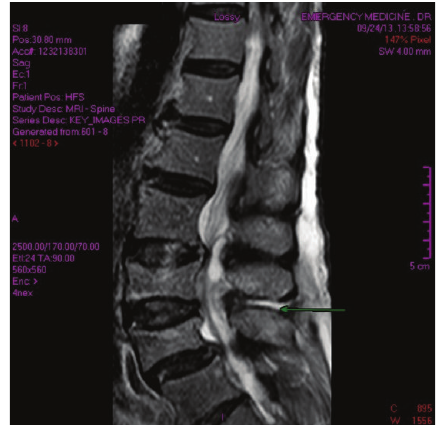
Figure 2: STIR (short-inversion-time inversion recovery) sagittal image. Increased fluid signal intensity is noted in the interspinous region of L3/L4 consistent with extension of